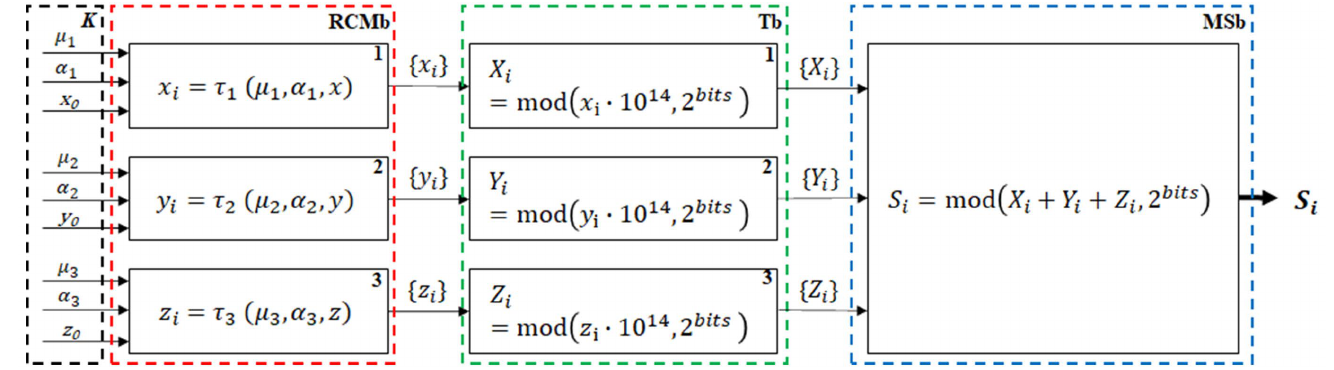
Figure 10. Block diagram of the proposed